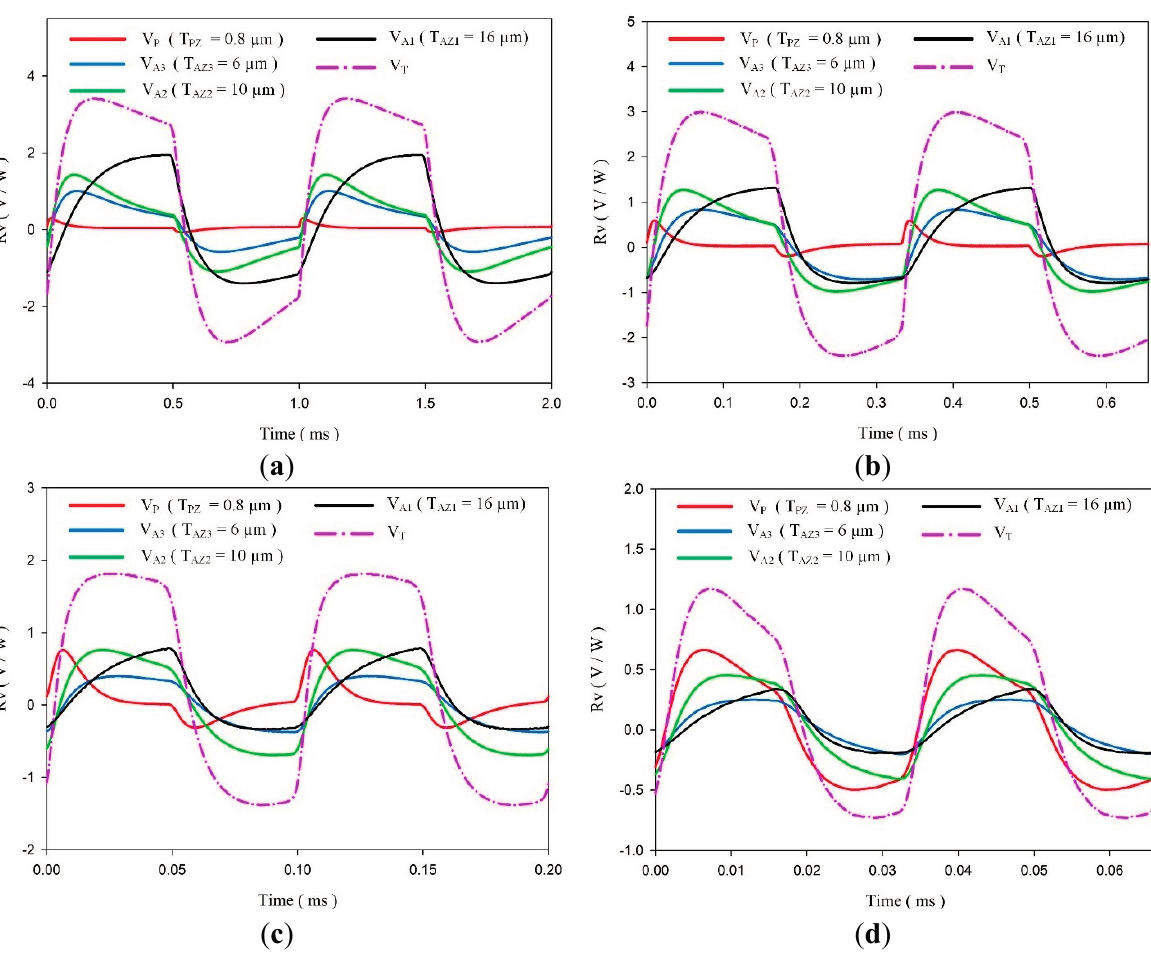
Figure 11. Measured Voltage responsivities of the meliorated multi-frequency band pyroelectric sensor with T PZ = 0.8 μ m, T AZ3 = 6 μ m, T AZ2 = 10 μ m and T AZ1 = 16 μ m